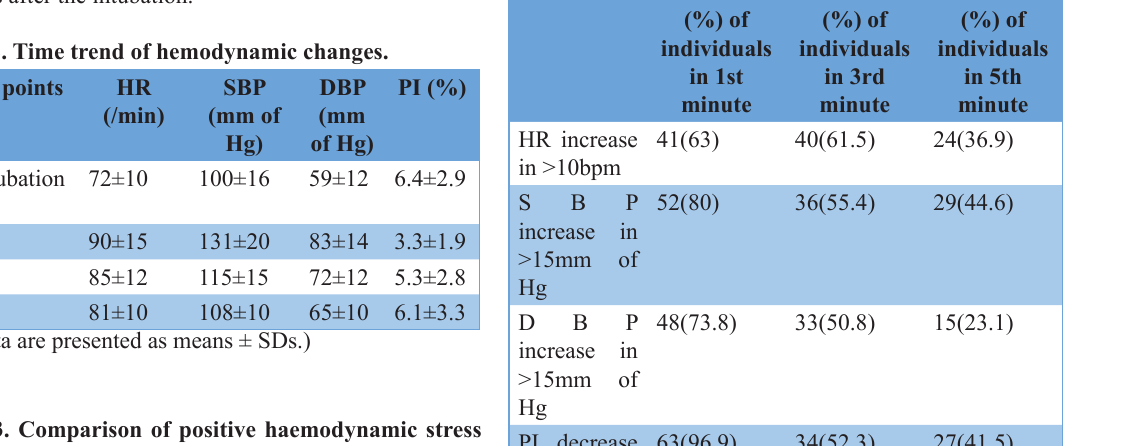
Table 3. Comparison of positive haemodynamic stress response HR, SBP, DBP and PI between preintubation values and at 1min, 3mins and 5 mins after intubation.